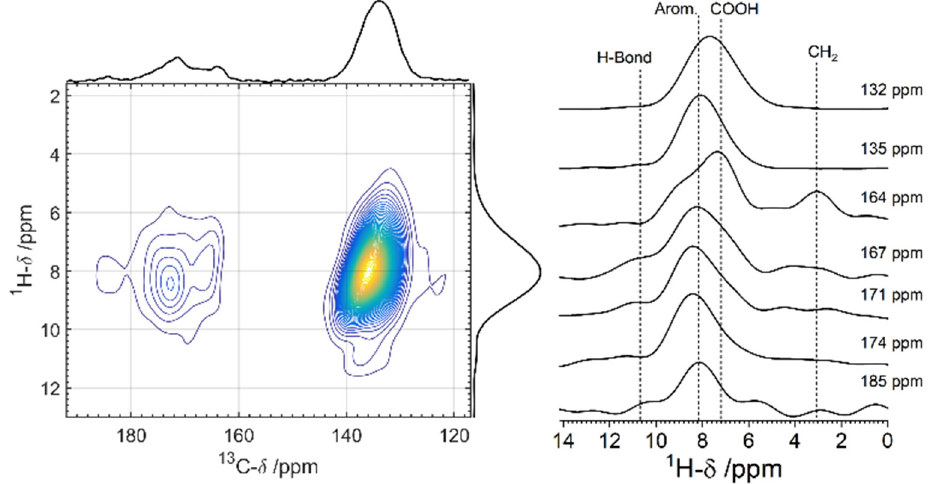
Figure 6. Two-dimensional 1 H{ 13 C} Double-CP HETCOR [(Eu 2 Zr)(btc) 3 (Hbtc) 0 . 5 ·6H 2 O)] ( left ) and traces taken from the vertical dimension, showing partial 1 H spectra (normalized by intensity) corresponding to several shifts of 13 C ( right ). The experiment was carried out under MAS conditions at 60 kHz with 1 H detection. The numbers indicated in the two-dimensional spectrum correspond to the carbon labeling in Figure 4.